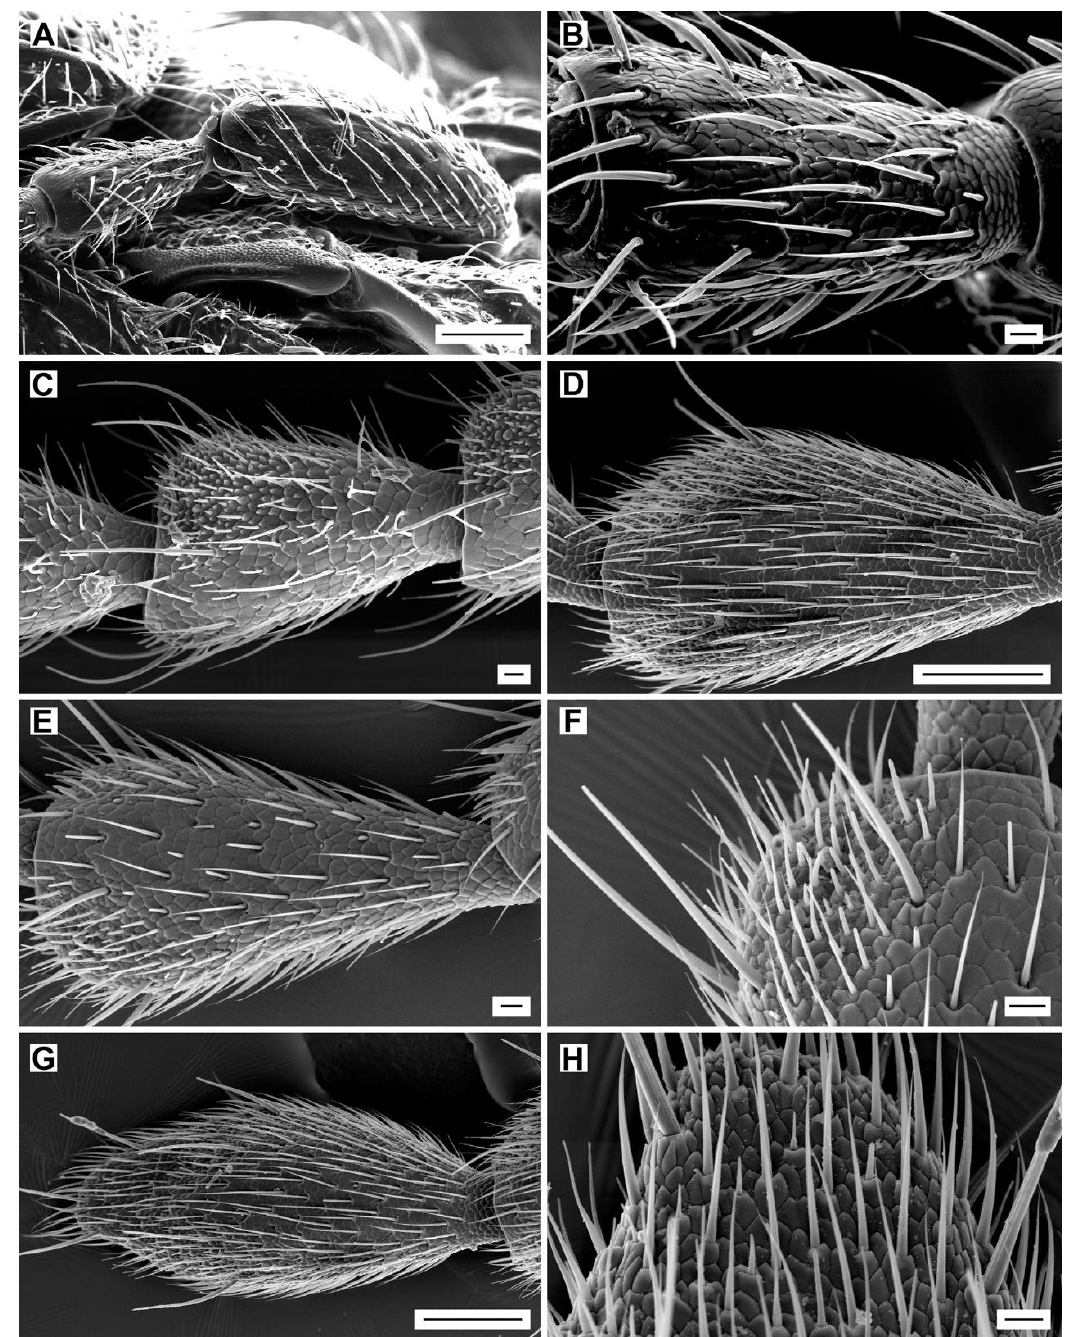
Figure 3. Surface of antennomeres and location of the sensillar fields. ( A ) A. medvedevi , male, antennomeres I and II, ventrally; ( B ) A. medvedevi , male, antennomere III, ventrally; ( C) A. acuminatus , male, antennomeres IV–VI, ventrally; ( D ) A. modestus , male, antennomere IX, dorsally; ( E ) A. medvedevi , male, antennomere X, dorsally; ( F ) dtto, detail; ( G ) A. modestus , male, antennomere XI, dorsally; ( H ) dtto, detail. Scale bars = ( A , D , G ): 100 μm; ( B , C , E , F , H ): 10 μm.